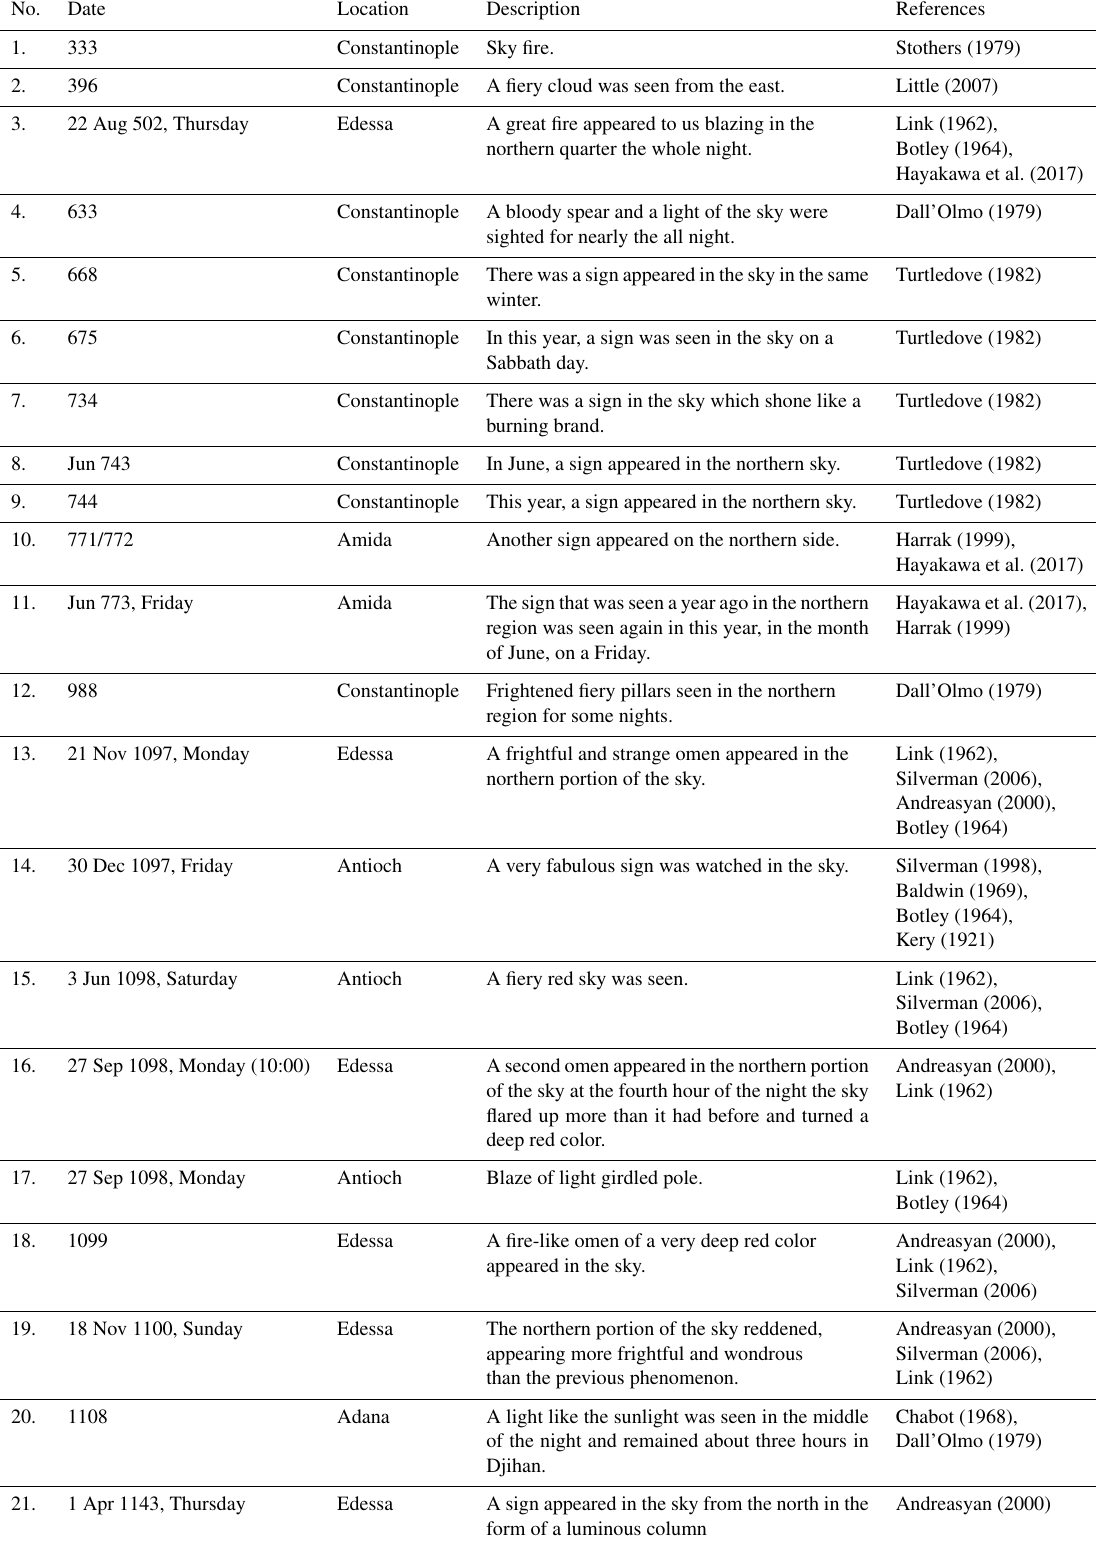
Table 2. Historical aurora catalogs during the Medieval period used in this